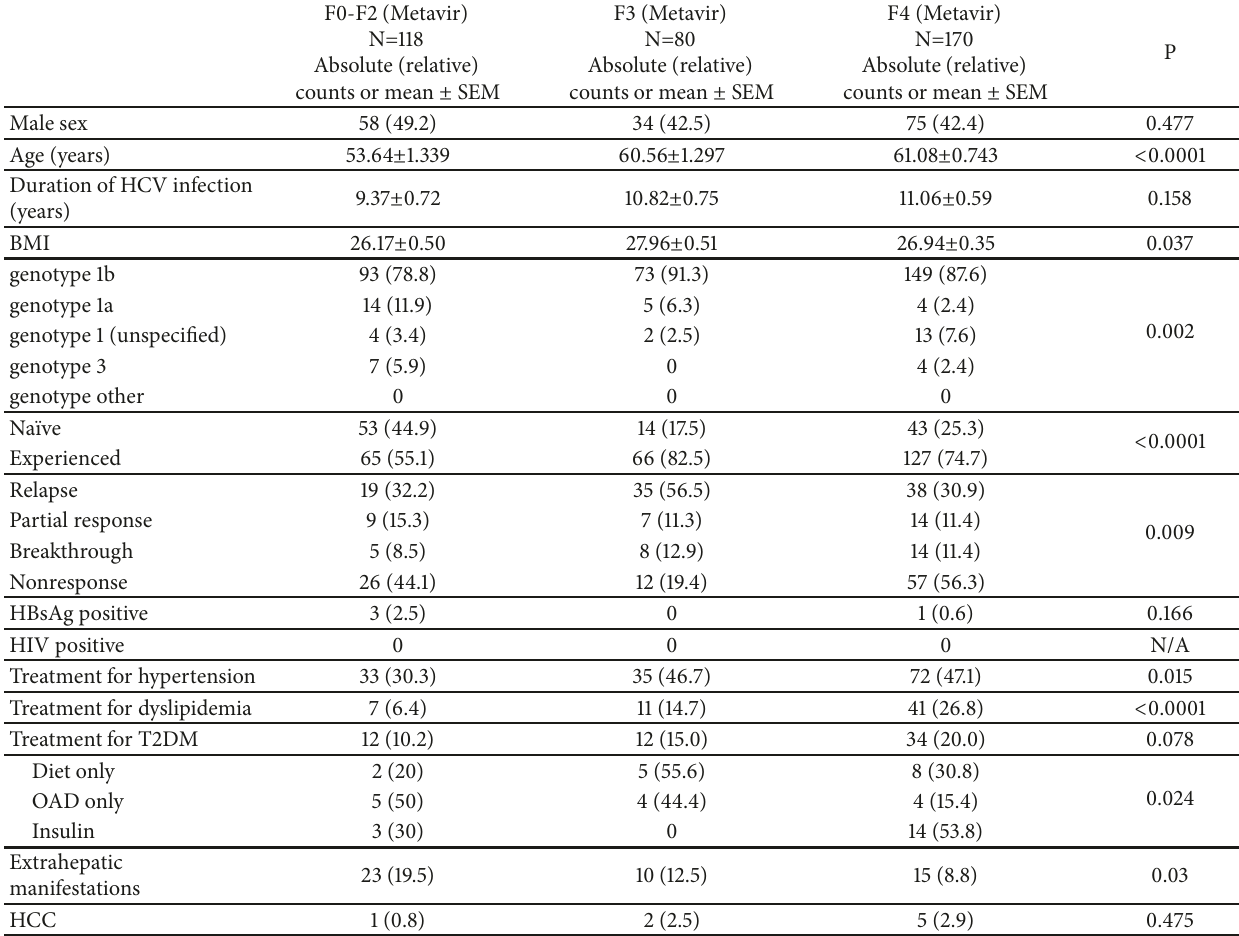
Table 1: Baseline parameters of the study cohort by degrees of